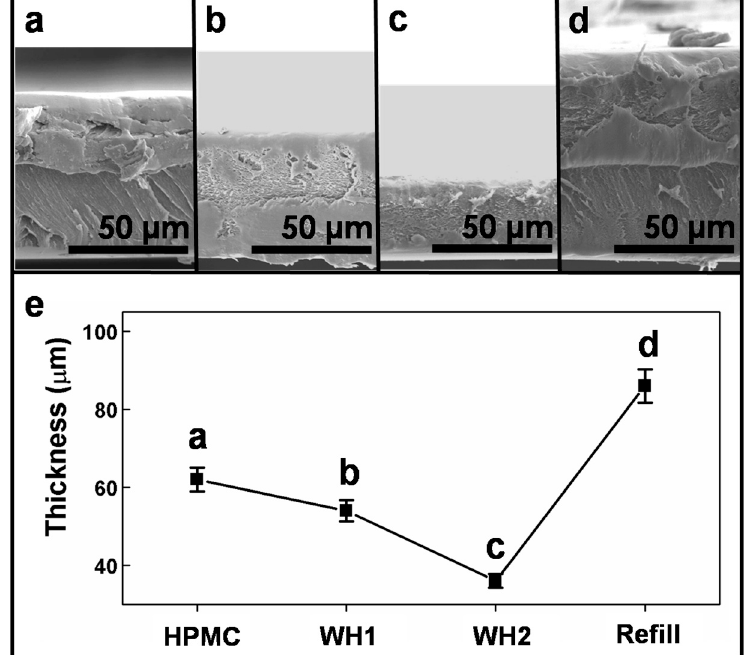
Figure 6. Film thickness ( a ) before healing process; ( b ) after first water healing treatment; ( c ) after second water healing treatment; ( d ) after HPMC refill treatment; ( e ) Variation of film thickness after the HPMC was healed and refilled.